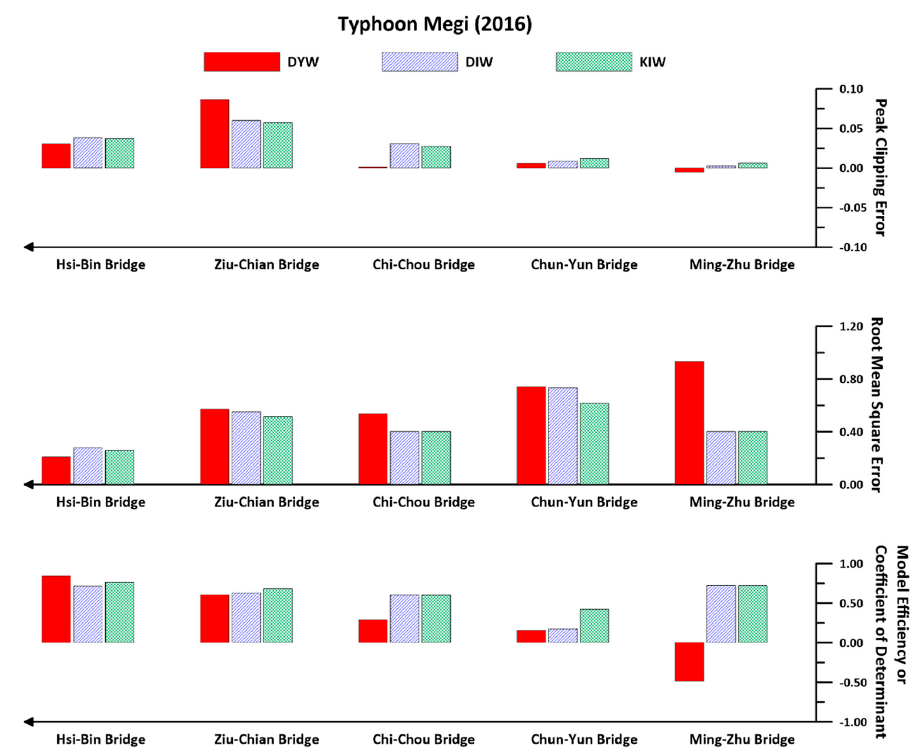
Figure 14. DYW/DIW/KIW simulation errors of Typhoon Megi (2016).